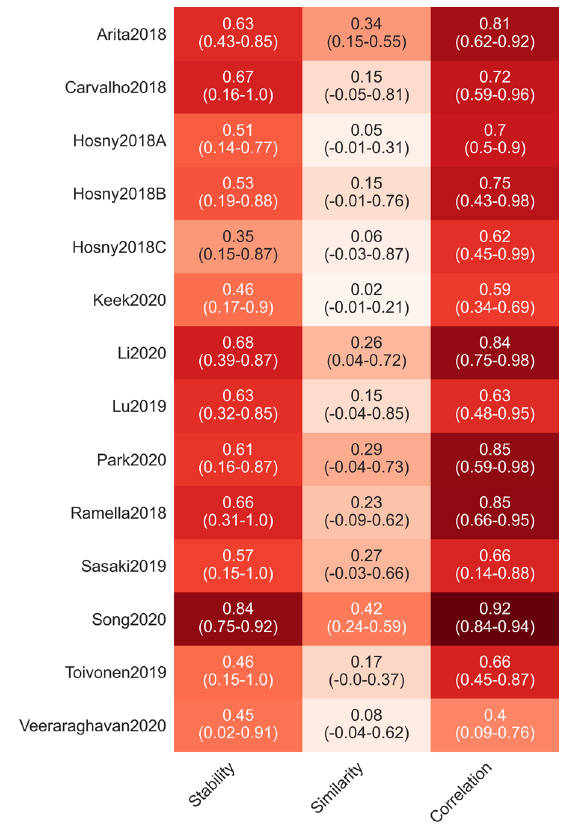
Fig. 4 Analyzed measured for all statistically similar models. The range is given in parentheses, the color of each cell corresponds to the stated